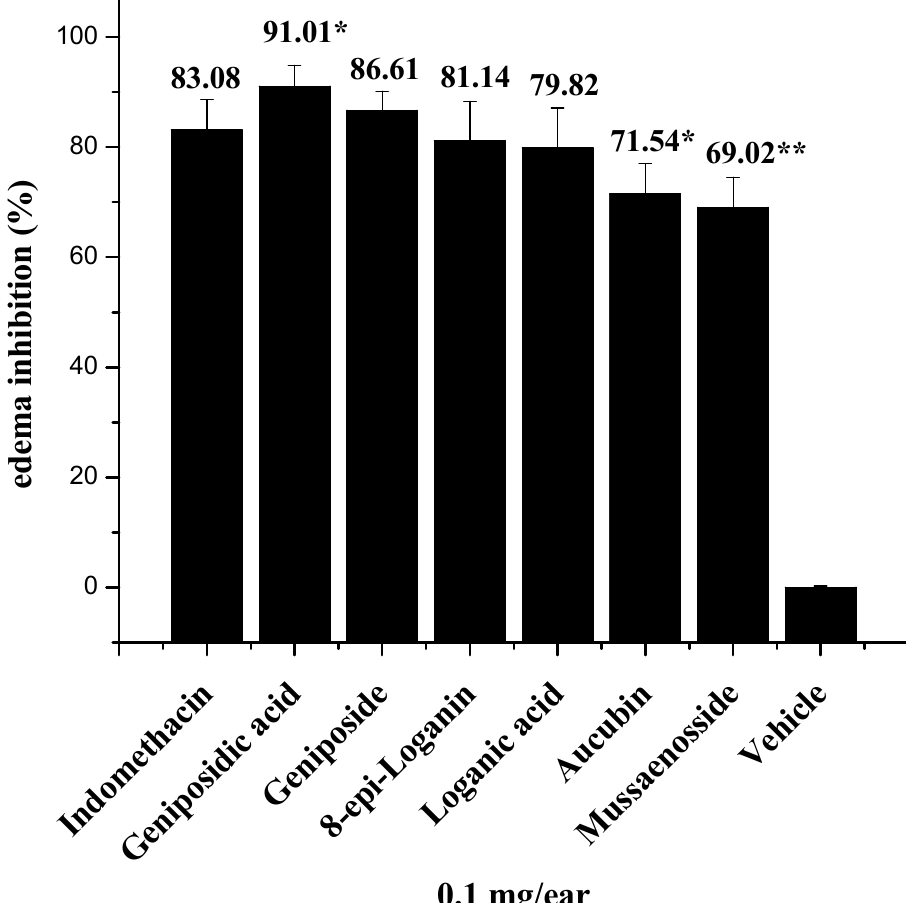
Figure 3. Effect of the iridoids isolated from the aerial parts of Castilleja tenuiflora on TPA-induced mouse ear edema. Groups of mice ( n = 5) were treated at 0.1 mg/ear.